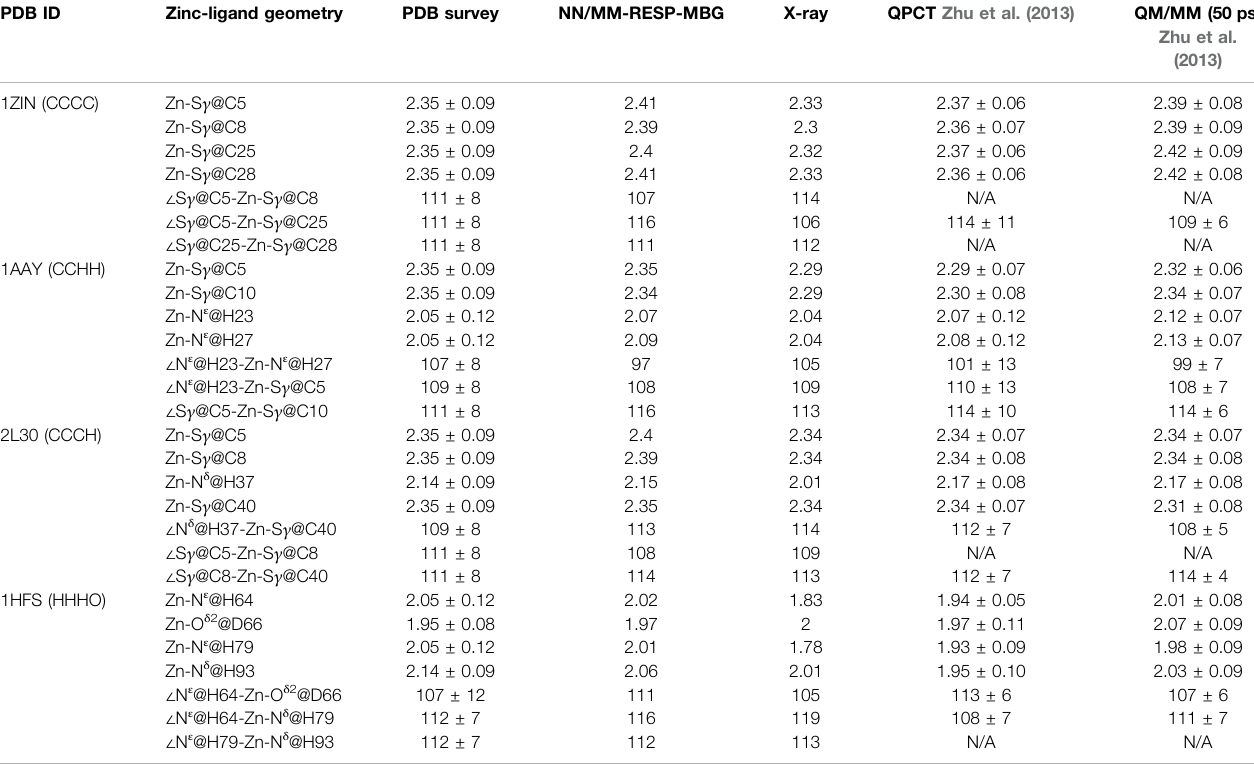
TABLE 3| Comparison ofcomputed average distancesand anglesbetween zinc and its ligated atoms ofdifferent zinc proteins with experimental measurements, statistical values (Alberts et al., 1998), and results from MD simulations with the QPCT (Zhu et al., 2013) force fi eld and QM/MM 13 (all the bond lengths are in Angstroms and bond angles in degrees). PDB